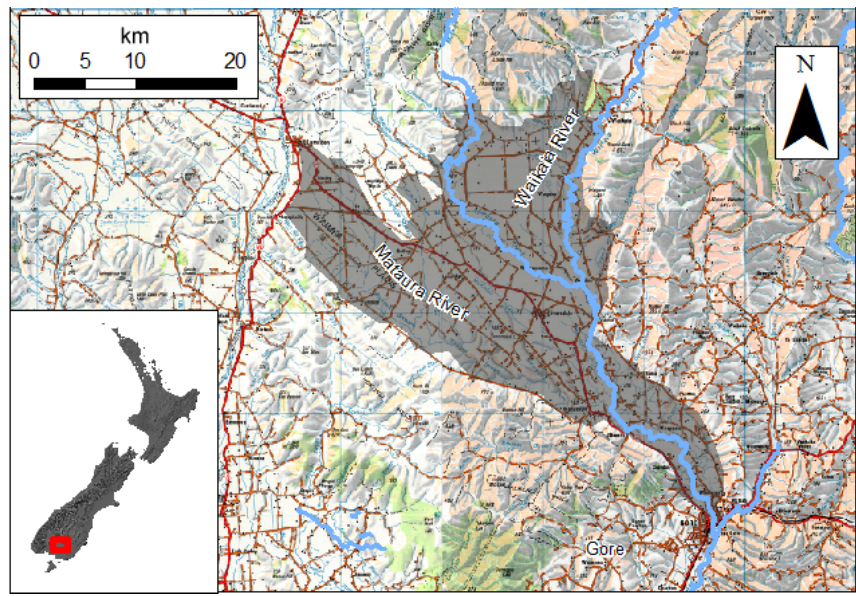
Figure B1. Model area of the Mataura catchment, Southland, New Zealand.